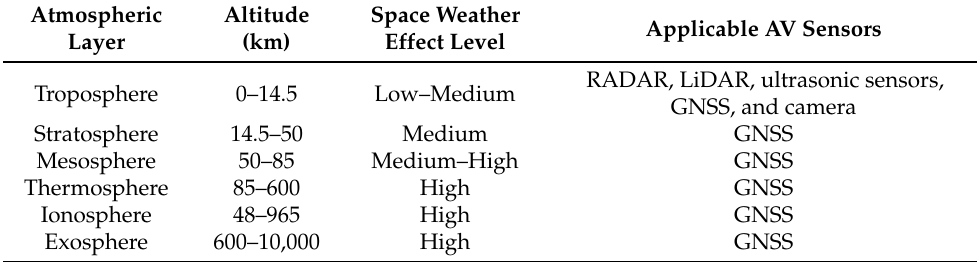
Table 5. Earth’s atmosphere